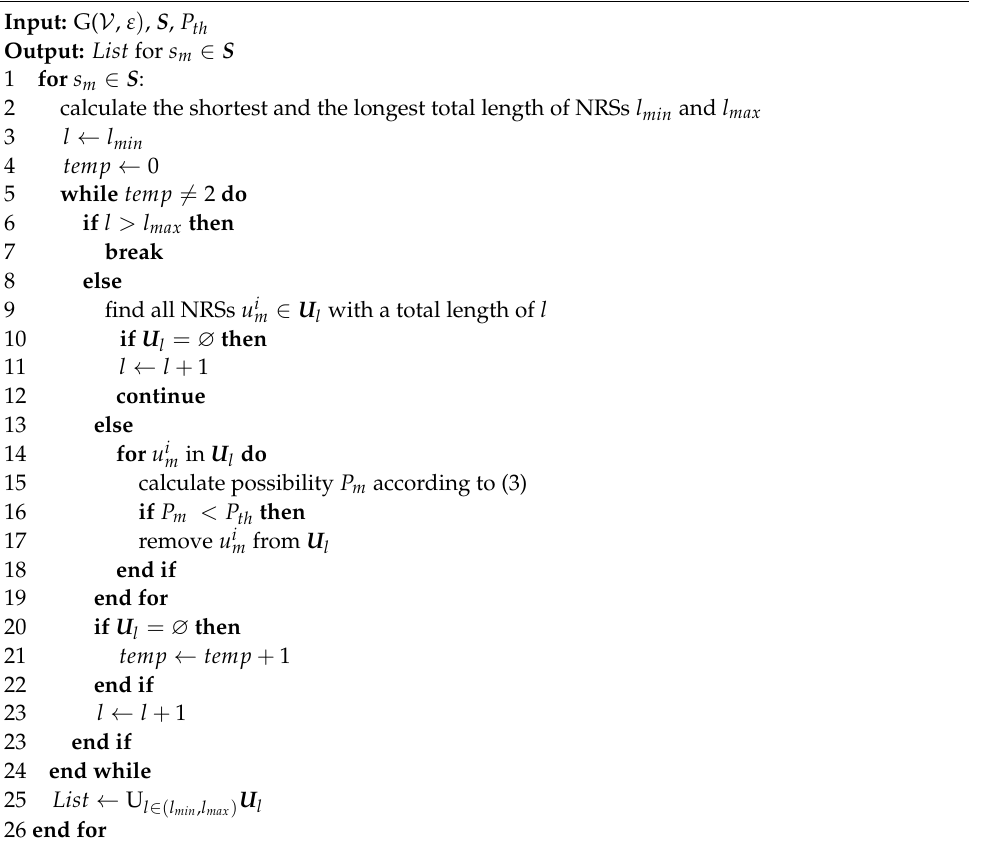
Algorithm 1 Candidate Routing Sets